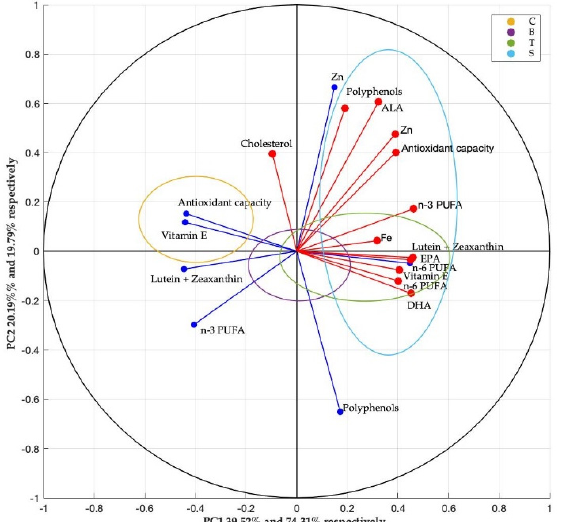
Figure 3. Biplot correlation circle from principal component (PC) analysis of plants (blue lines) and meat (red lines). PC1 covered 39.52% of variance in plants and 74.31% variance in meat. PC2 covered 20.19% variance in plants and 19.79% variance in meat.